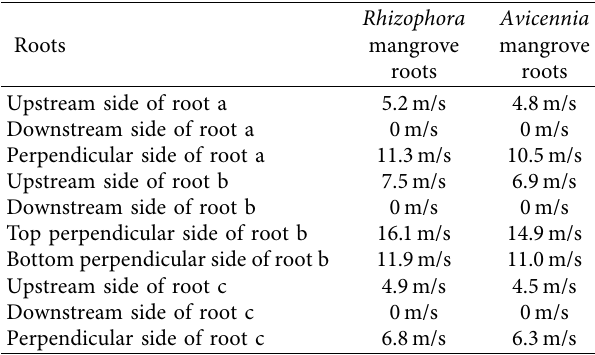
Table 1: Comparison of velocity of 3 different roots at different positions of incompressible unsteady air flow within 4 seconds.